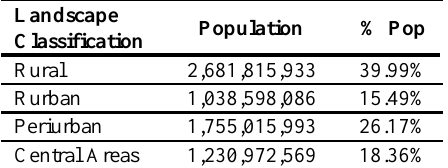
Table 4. Population by Landscape